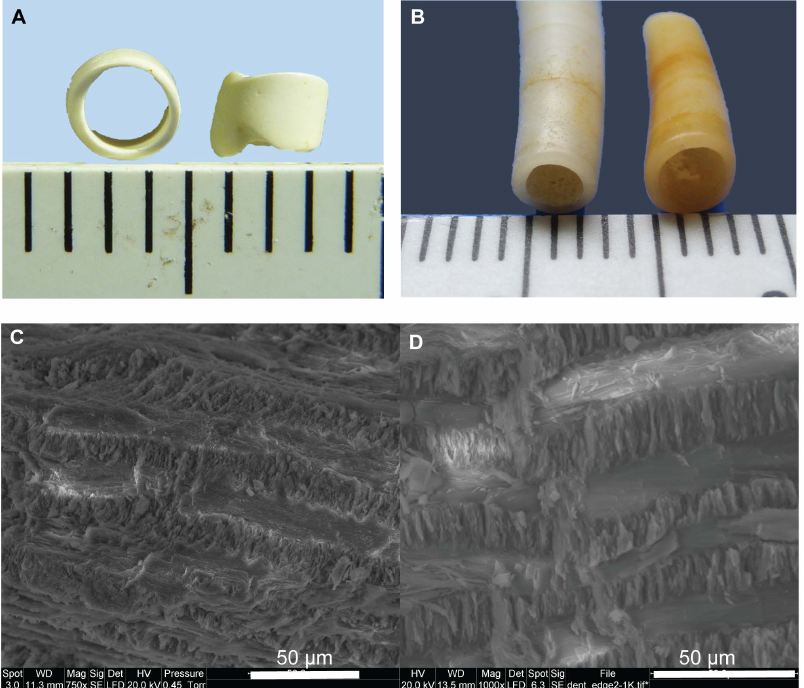
Figure 6. Great Cornard bead 3870 and Antalis sp. Photograph (a, b) and scanning electron microscopy images (c, d) of bead 3870 (a, c) and Antalis sp. (b,